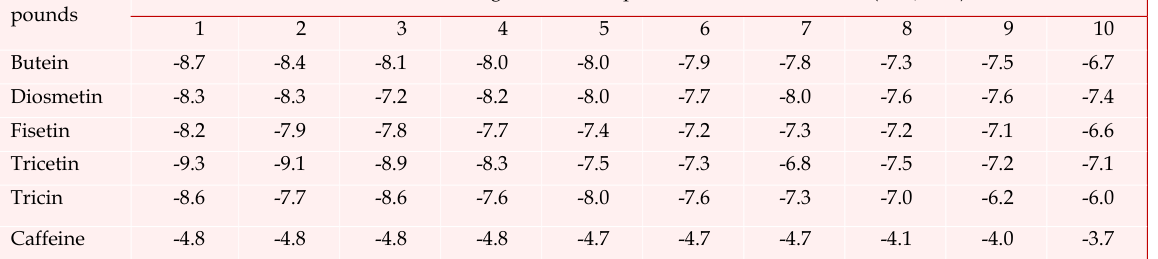
Intermolecular energies of the compounds based on their